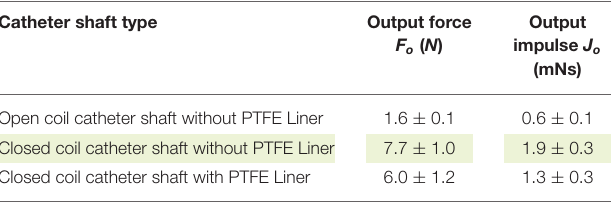
TABLE 2 | Overview of the results (mean ± standard deviation, n = 3) of the catheter shaft type experiment. Catheter shaft